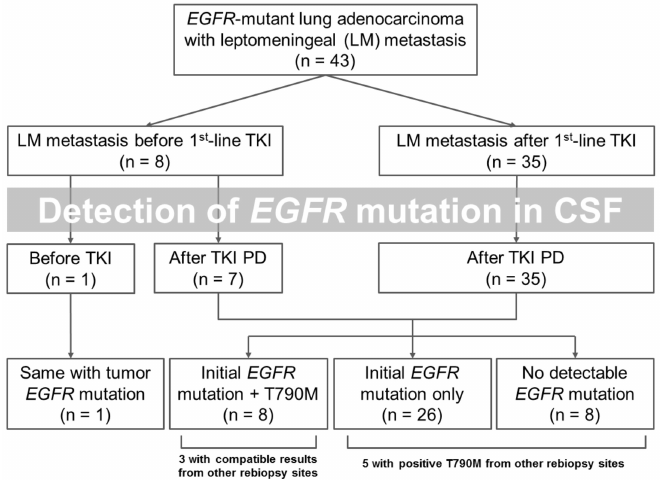
Figure 1. Timing and results of EGFR mutation detection in CSF specimens.